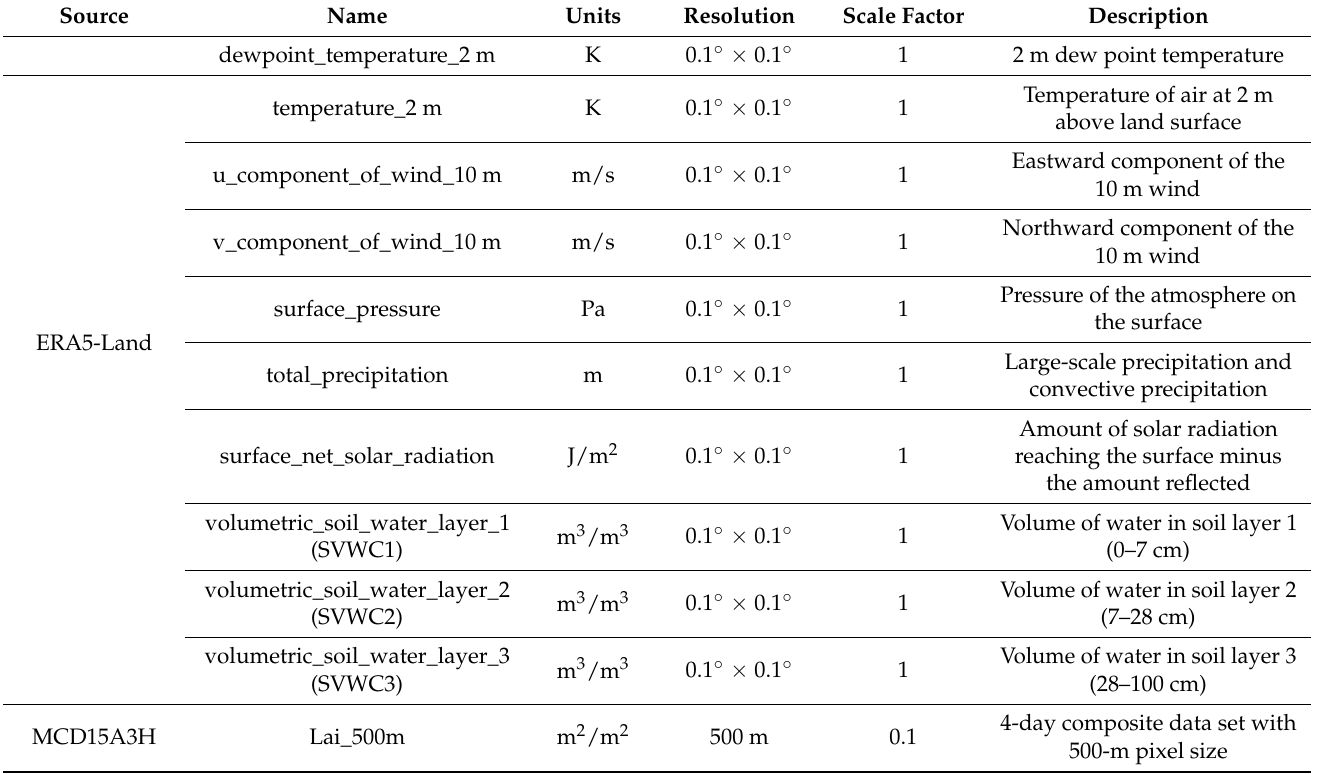
Table 5. Detailed parameters for the remote sensing data